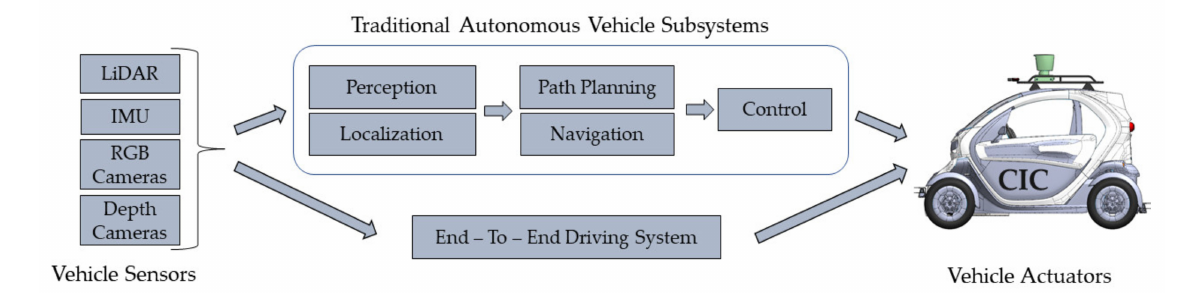
Figure 1. Traditional driving systems compared to end-to-end driving